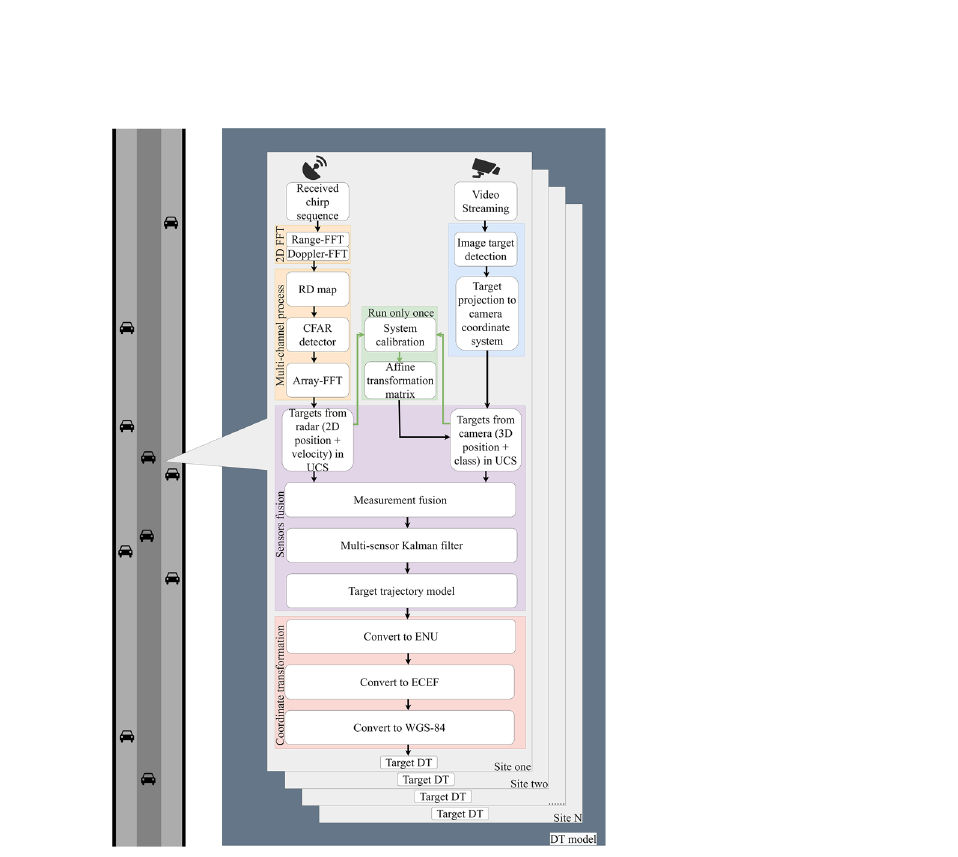
Figure 8. End to end DT generation